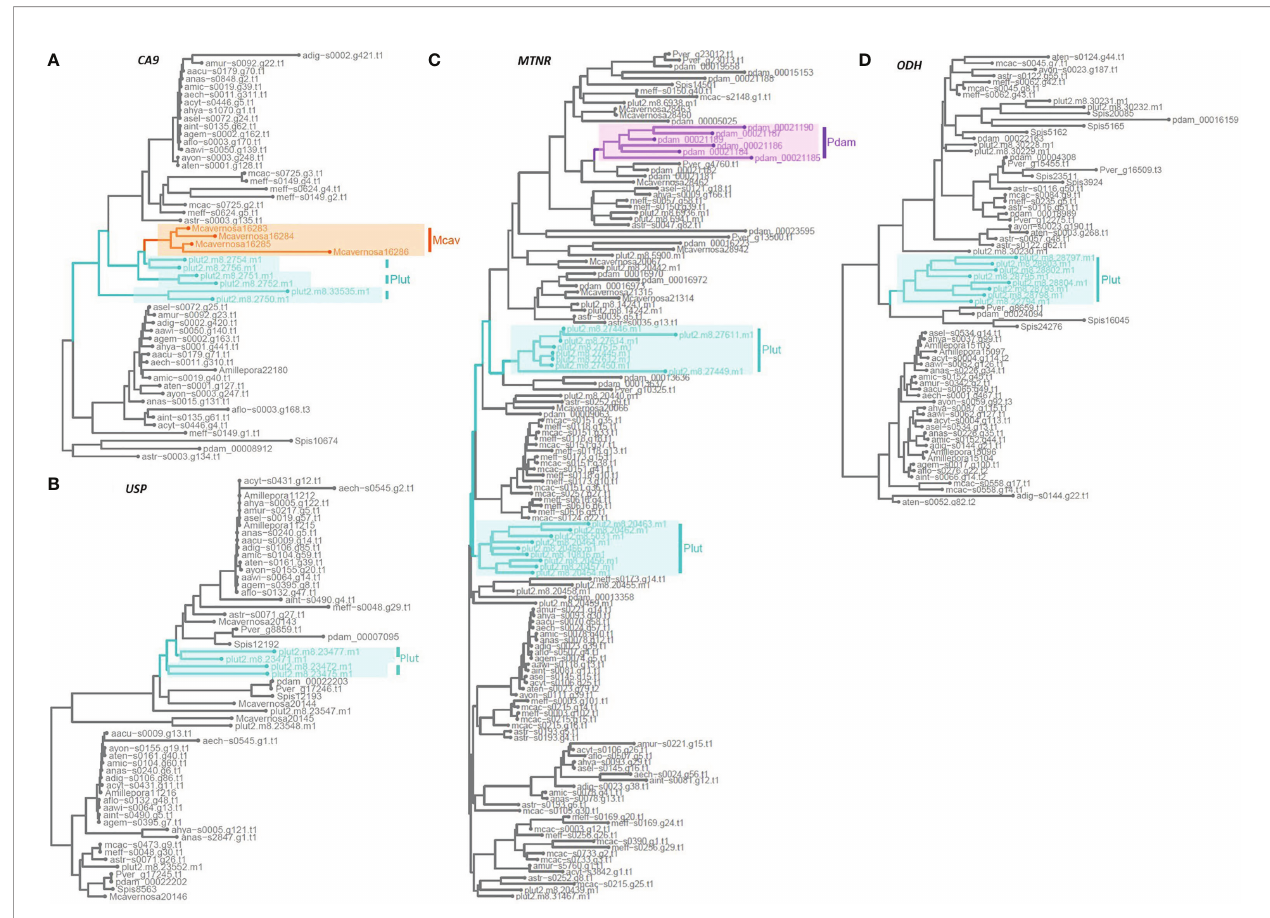
FIGURE 3 | Rooted phylogenetic gene trees across 24 coral species showing species-speci fi c expansions of hypoxia-associated genes that exhibit disparate copy number variation: (A) Carbonic anhydrase 9, CA9 ; (B) Universal stress protein, USP ; (C) Melatonin receptor, MTNR ; (D) Octopine dehydrogenase, ODH . Species- speci fi c expansion of > 2 genes in a cluster for each gene family is indicated by the following highlighted boxes: Plut, Porites lutea in turquoise; Pdam, Pocillopora damicornis in purple; and Mcav, Montastraea cavernosa in